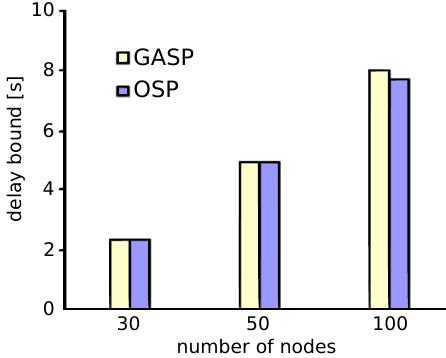
Figure 11. The worst case delay comparison of OSP vs. GASP.